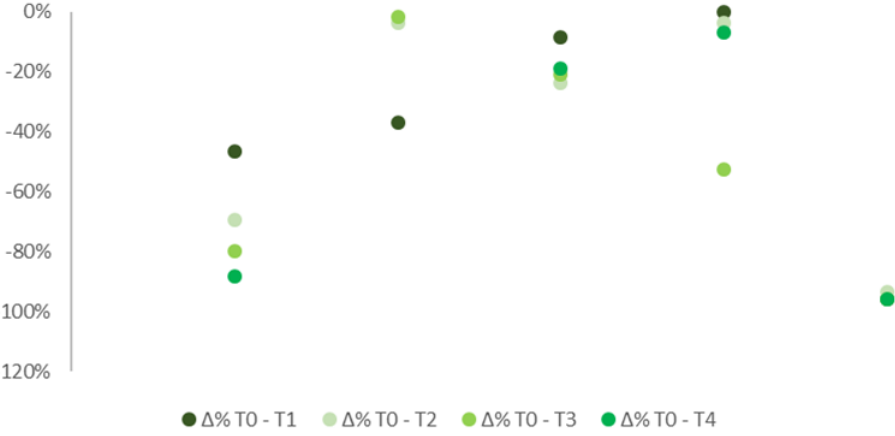
Figure 4. % differences in pain median levels at T0, T1, T2, T3, and T4 in patients with ONP. Patients with FS asserted furthermore benefits concerning several other symptoms.